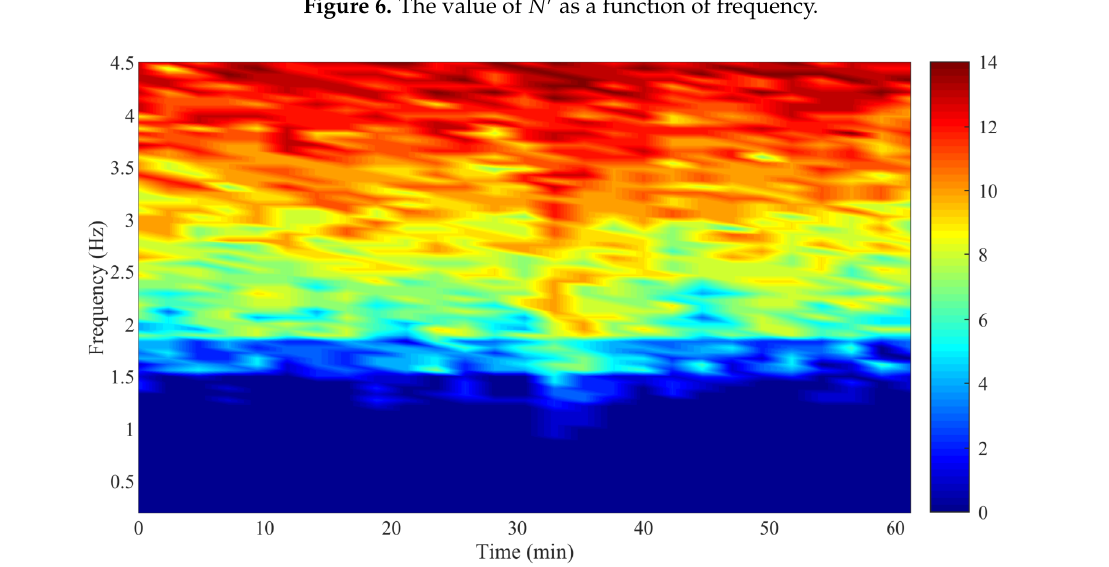
Figure 7. The value of K as a function of frequency and time. The chosen gather is marked in red in Figure